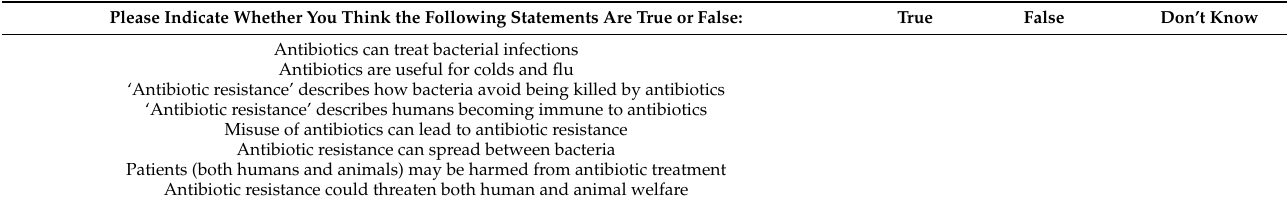
Table A2. Antibiotic knowledge scale.